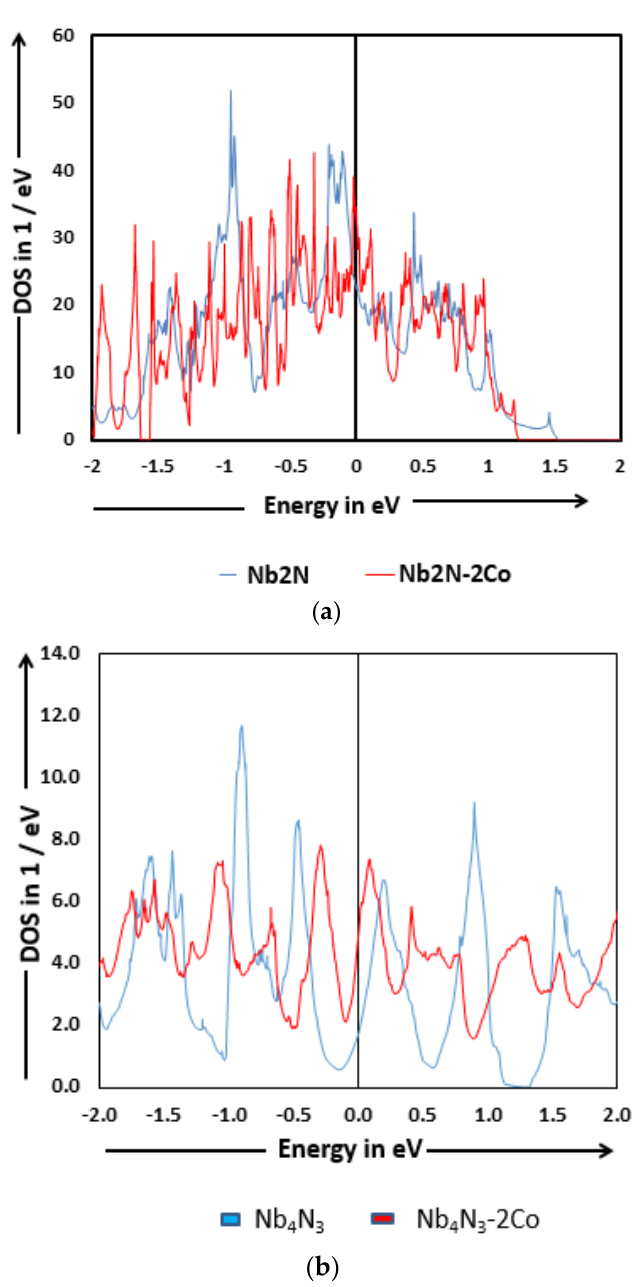
Figure 6. Comparison of the density of states at and near Fermi Level of ( a ) Nb 2 N and Nb 2 N-2Co; ( b ) Nb 4 N 3 and Nb 4 N 3 -2Co. ( b ) Nb 4 N 3 and Nb 4 N 3